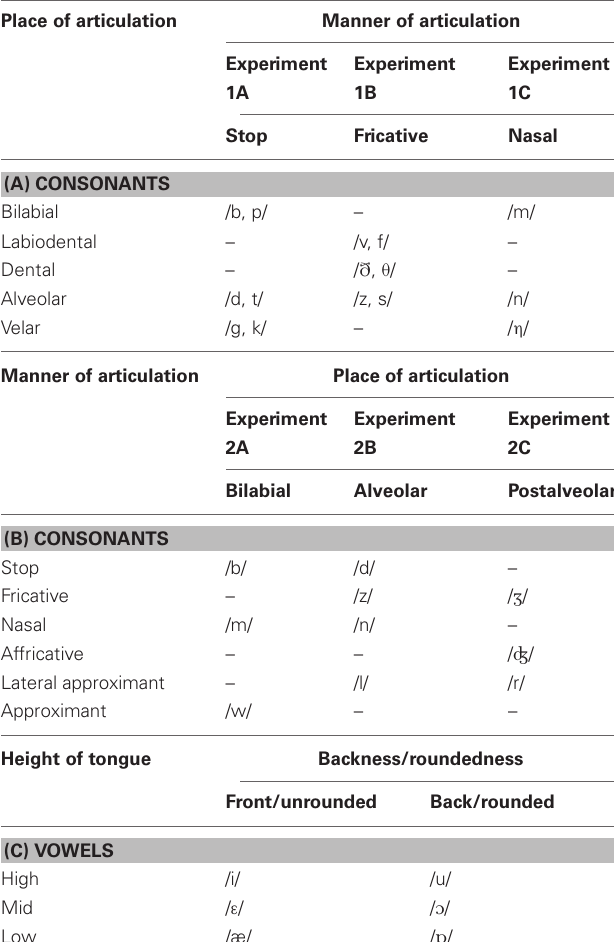
Table 1 | The main articulatory features used to categorize the consonant and vowel stimuli used in Experiments 1–3, as a function of: (A) the place of articulation, (B) the manner of articulation, and (C) the height and backness of the tongue and roundedness of the lips in Experiments